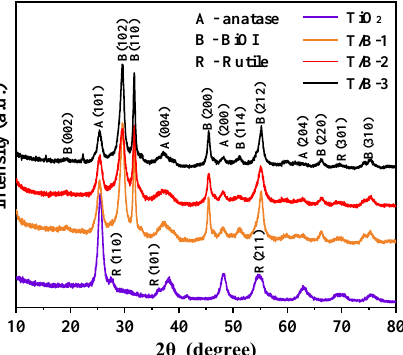
Figure 5. XRD patterns of TiO 2 , T/B-1, T/B-2, and T/B-3 composite fibers. The XRD results of composite fibers with different proportions of BiOI and TiO 2 show that only two characteristic peaks of BiOI and TiO 2 phases can be identified, and no other new substances were generated. For the measured BiOI diffraction peak signals located at 19.3°, 29.6°, 31.6°, 45.3°, 55.1°, 51.3°, 66.1°, and 75.1°, corresponding to crystal planes (002), (102), (110), (200), (212), (114), (220), and (310), respectively, this matches well with the phase of BiOI (PDF#10-0445) [36]. This indicates that BiOI has been successfully synthesized on TiO 2 . With the continuous increase in BiOI concentration, the phases of TiO 2 anatase and rutile gradually weakened, and the fibers were basically covered, which was consistent with the morphology observed by SEM. From the above analysis, it can be basically judged that when the concentration of BiOI precursor reaches the composite condition of T/B-2, a relatively good composite mor- phology is formed. In order to further confirm the generation of heterojunction structures, Raman test is needed to detect TiO 2 , T/B-1, T/B-2, and T/B-3 fibers, the results are shown in Figure 6.